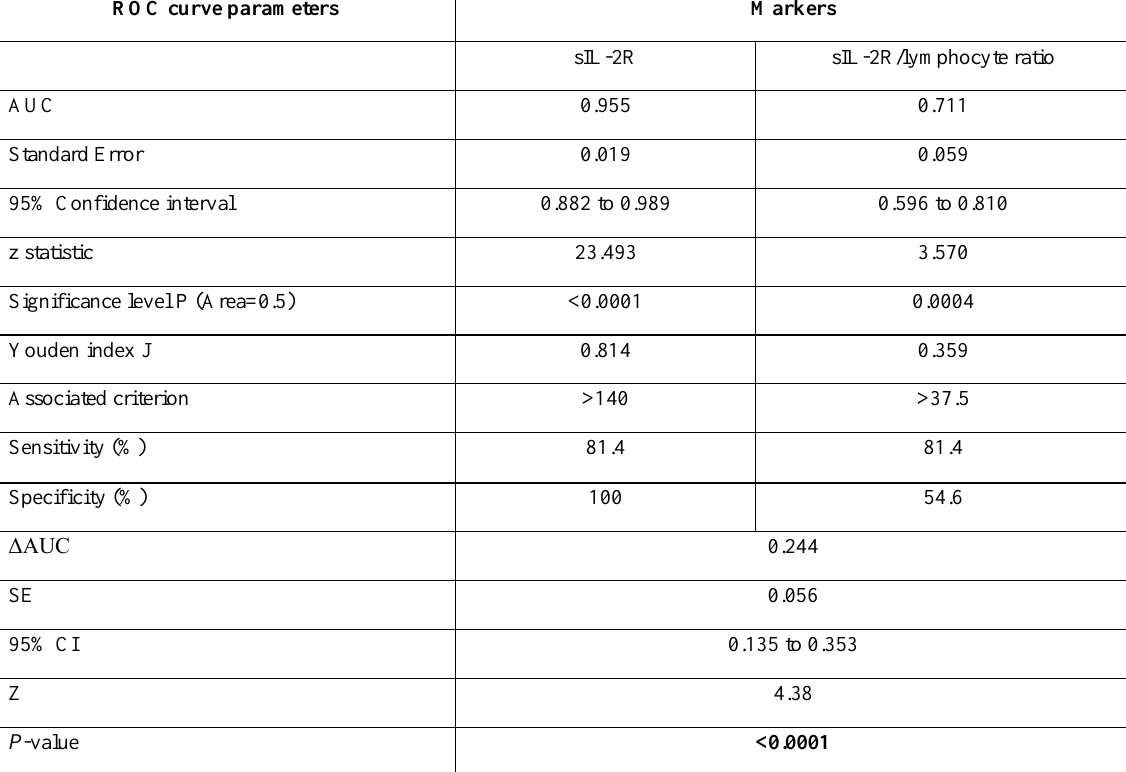
Table 3. Performance of sIL-2R or sIL-2R/lymphocyte ratio in discrimination between patients with mild to moderate COVID-19 (group I) and those with severe to critical COVID-19 (group II).